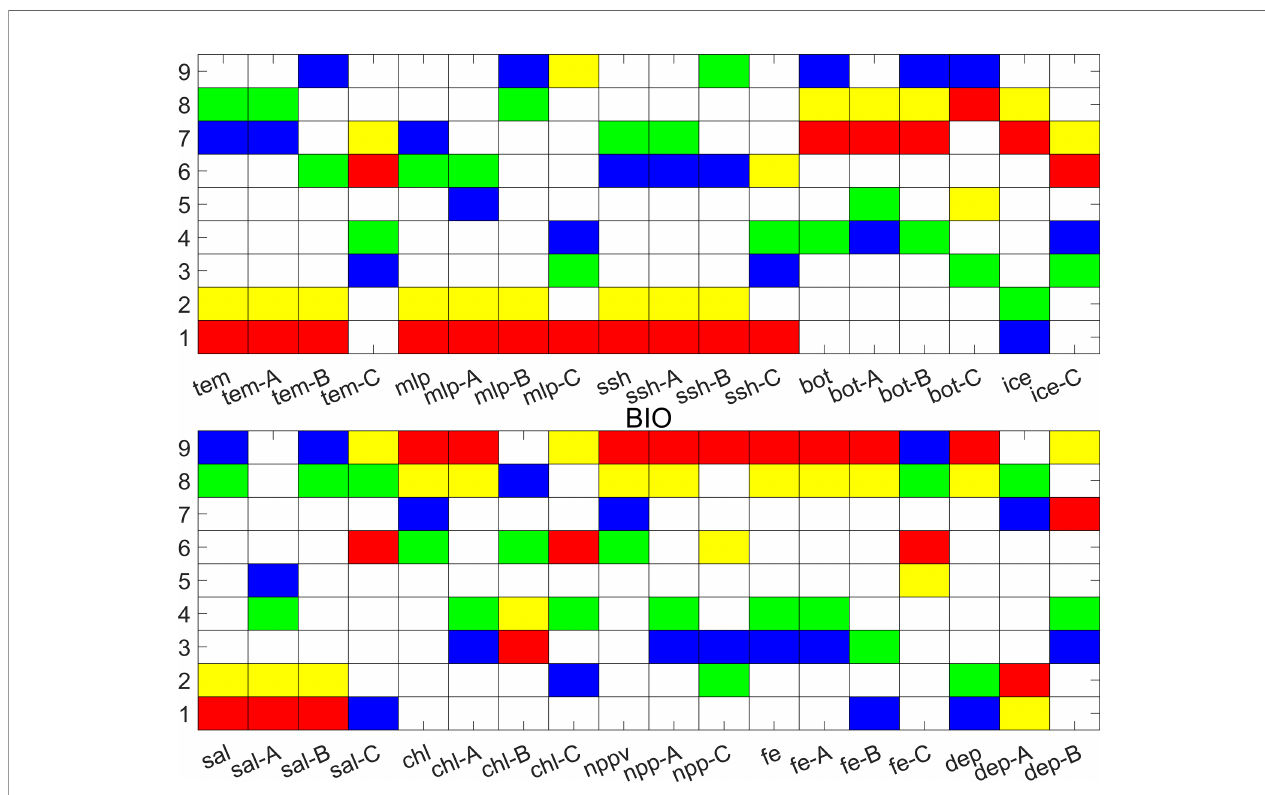
FIGURE 5 | Parameters that characterize the key properties of bioregions, showing the maximum value (red), the second-highest value (yellow), the minimum value (blue) and the second-lowest value (green) of each parameter, including the annual maximum mean (A) , annual minimum mean (B) , and long-term change rate (C) (dep-A: latitudinal gradient, dep-B: longitudinal